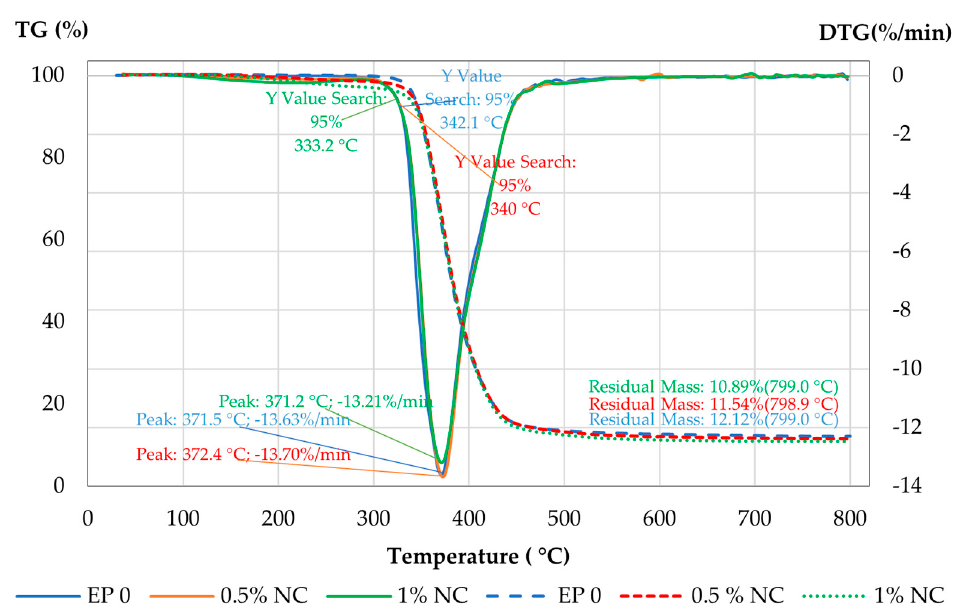
Figure 11. Comparison of TGA for NC composites.